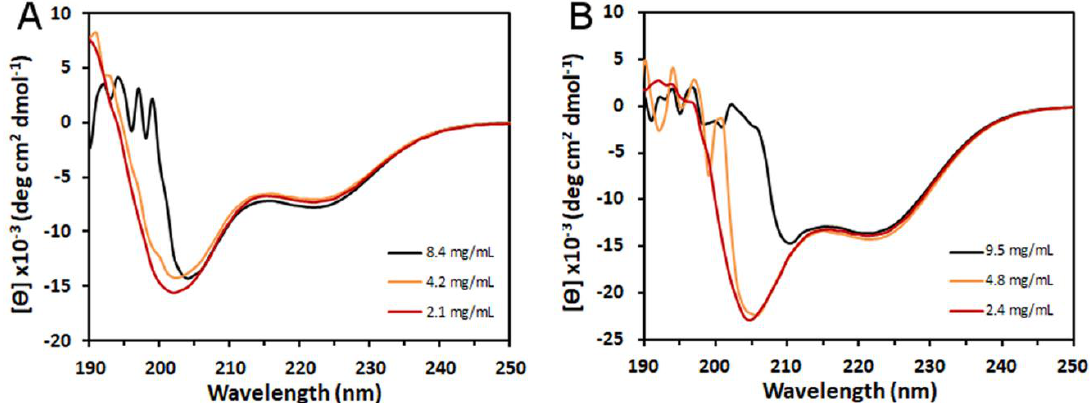
Figure 3. Circular dichroism spectra for peptides AR28 ( A ) and AR99 ( B ) as a function of concentration.